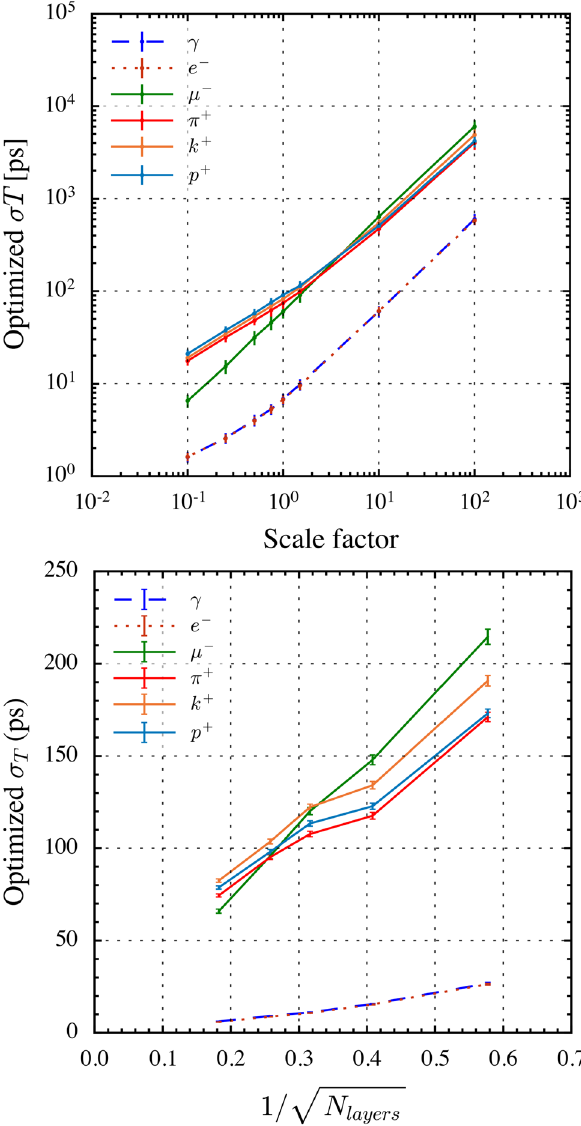
Fig. 12 The scaling behavior of the shower time resolution for 10 − 15GeV particles versus the intrinsic hit time resolution (top) and the number of timing layers (bottom). α denotes the scale factor in Eq.